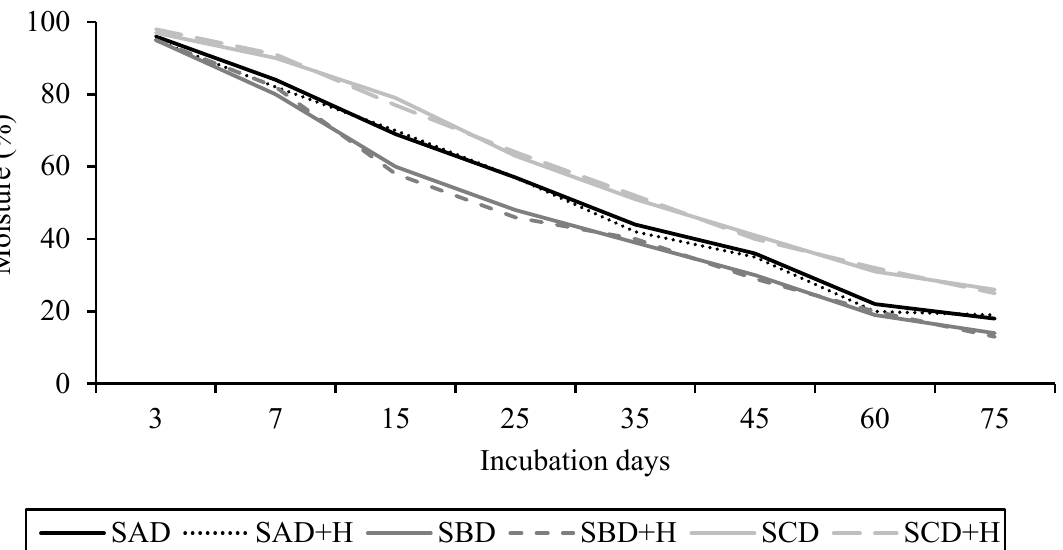
Figure 2. Changes of moisture (%) relative to the WHC (mean ± standard error, n = 3) concentration in non-watered soils with MCPA during the experimental period under drought conditions.